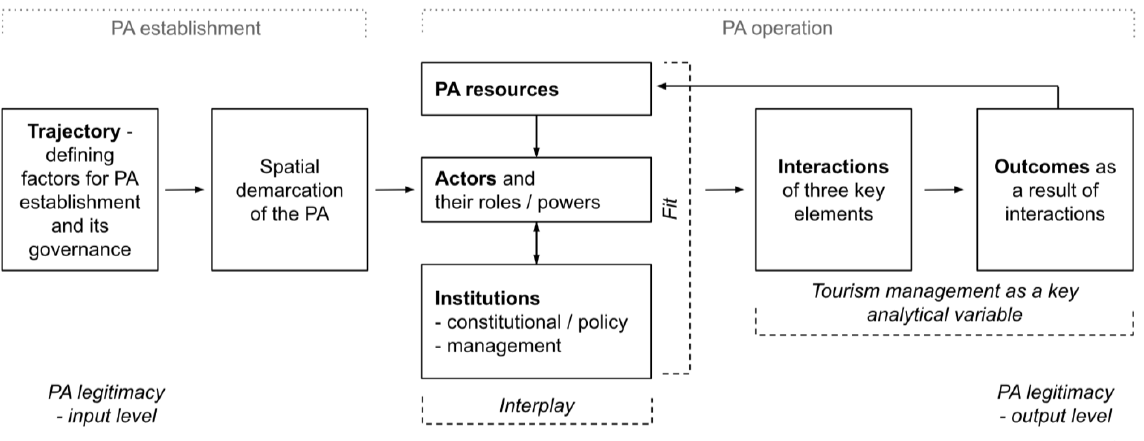
Figure 1. Environmental governance system (EGS) framework for the analysis of PAs (adapted and expanded from [2] ).